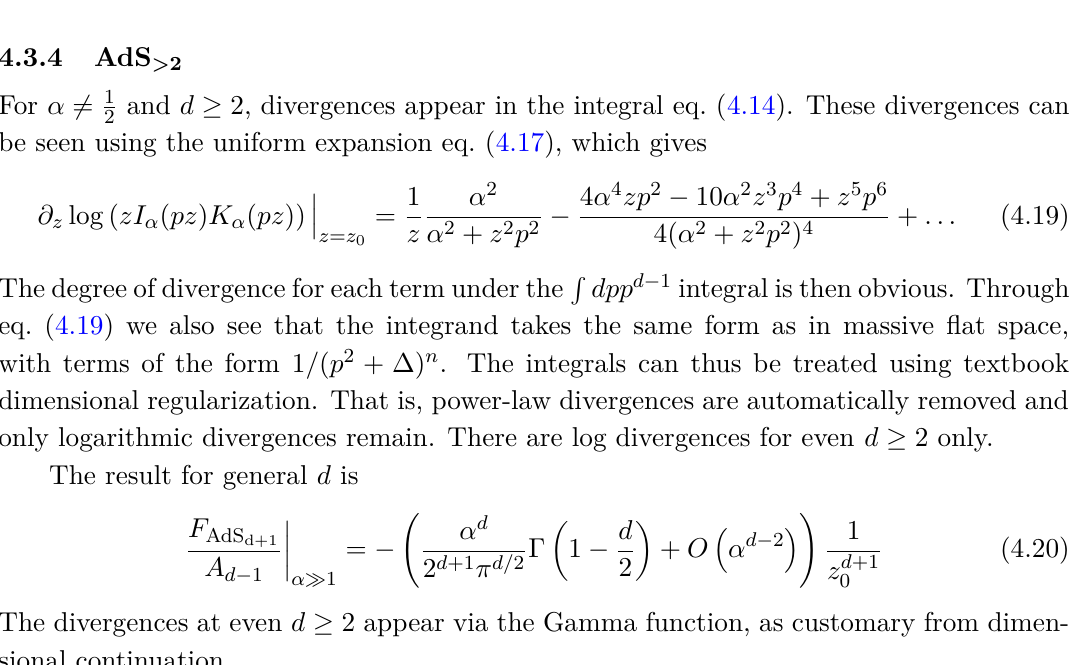
Figure 4 . Force from the quantum vacuum felt by a point particle in AdS 2 in the presence of a scalar field with mass m 2 = ( α 2 − 1 ) k 2 . For a conformally massless scalar α = 1 4 Casimir force between the particle and the boundary is recovered. For any α the point particle is attracted towards the AdS boundary. The dotted line shows the result from large mass expansion, eq.